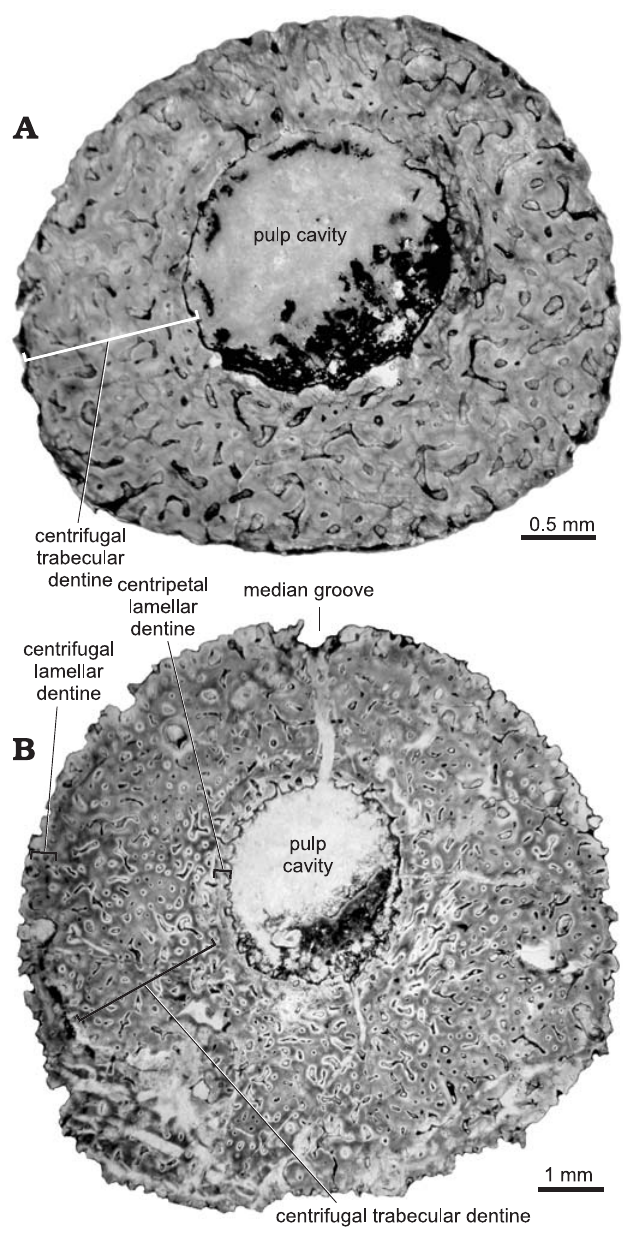
Fig. 6. Cross-sections of dorsal spines (non-denticulated region) of Ortha- canthus platypternus (Cope, 1884), Lower Permian, Craddock Bone Bed, Texas, USA. Comparison between the smallest, specimen HMNS-T1 ( A ), and the largest Orthacanthus dorsal spine sampled, specimen HMNS-J1 ( B ). Posterior sides of the spines are pointing to the top of the